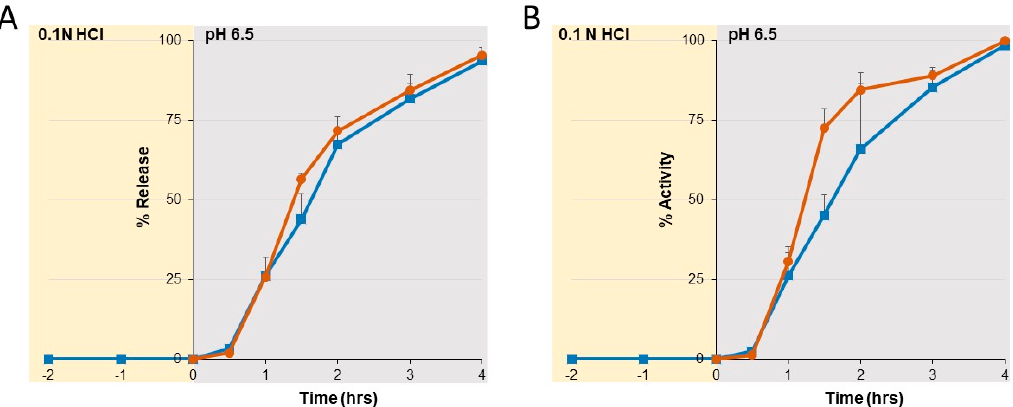
Figure 5. Dissolution of enteric-coated pellets containing P2A (SYN-006). SYN-006 pellets, composed of enteric-coated P2A, were held at low pH (0.1 N HCl) for two h after which the pH was raised to 6.5 (blue squares) or were exposed to pH 6.5 bu ff er alone (orange circles). ( A ) Kinetic enzyme dissolution (% release) of P2A enzyme from SYN-006 pellets assessed by ultraviolet (UV) absorbance. ( B ) Activity (%) of P2A enzyme released from SYN-006 pellets.